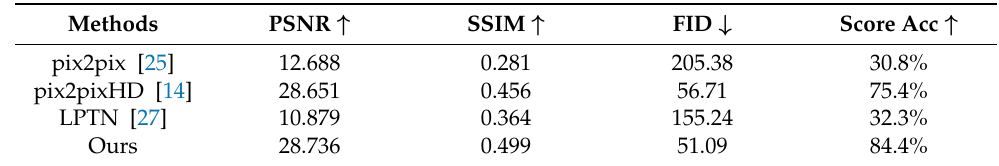
Table 3. PSNR, SSIM, FID, and scoring accuracy of our method compared to that of state-of-the- art